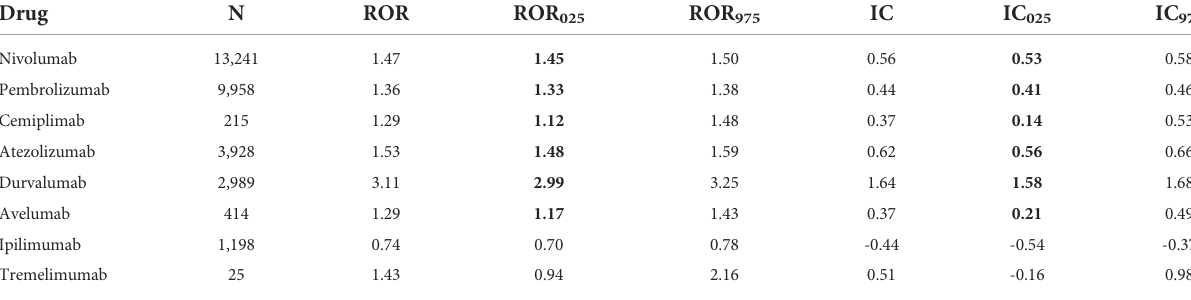
TABLE 4 The associations of respiratory system AEs with different ICI regimens.